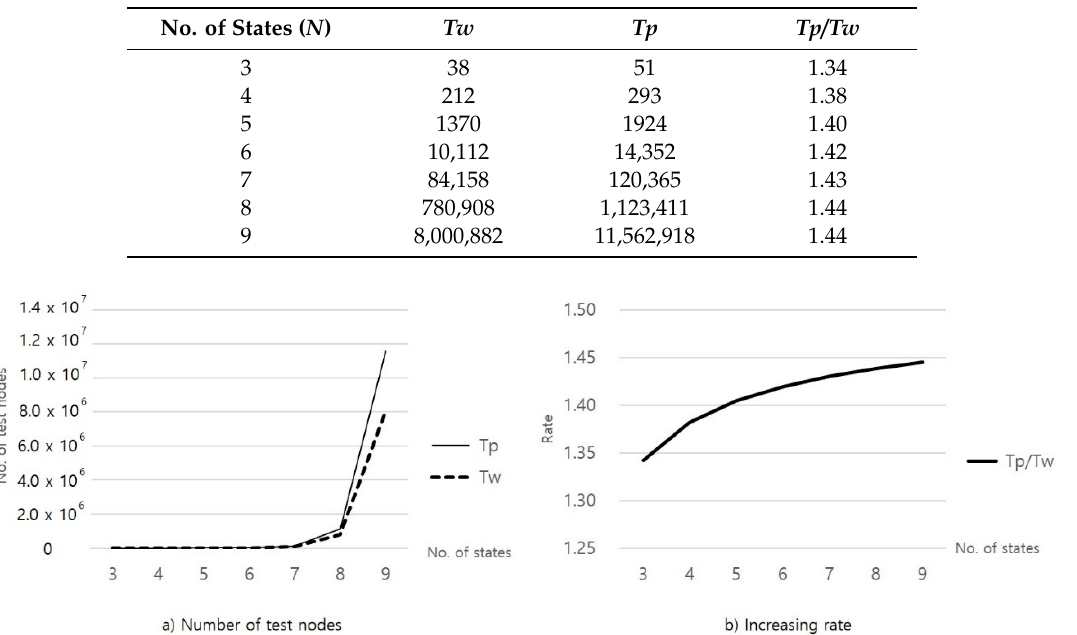
Table 3. Results of Tw and Tp .